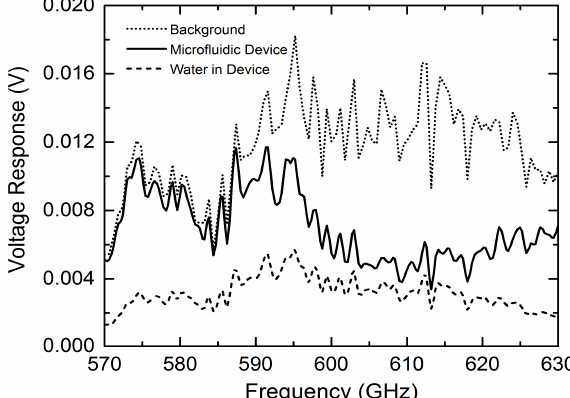
Figure 4. Measured THz responses (raw data without normalization) for background (ambient), empty microfluidic device and water-filled microfluidic device, respectively [26].